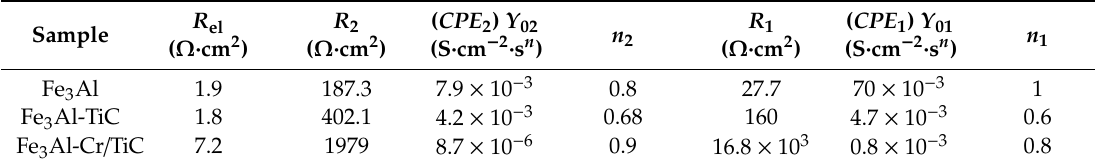
Table 4. Impedance fitting